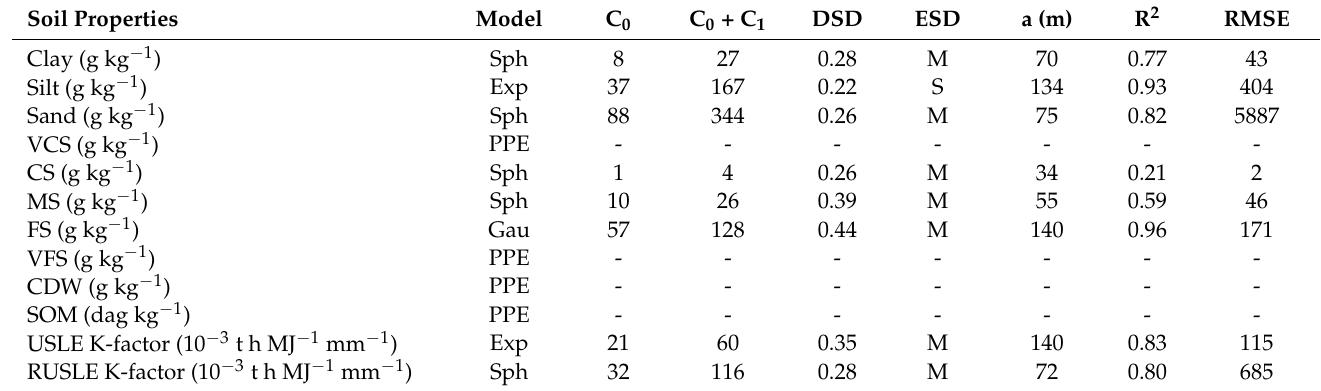
Table 2. Estimated model and parameters of the semivariograms of the soil properties.